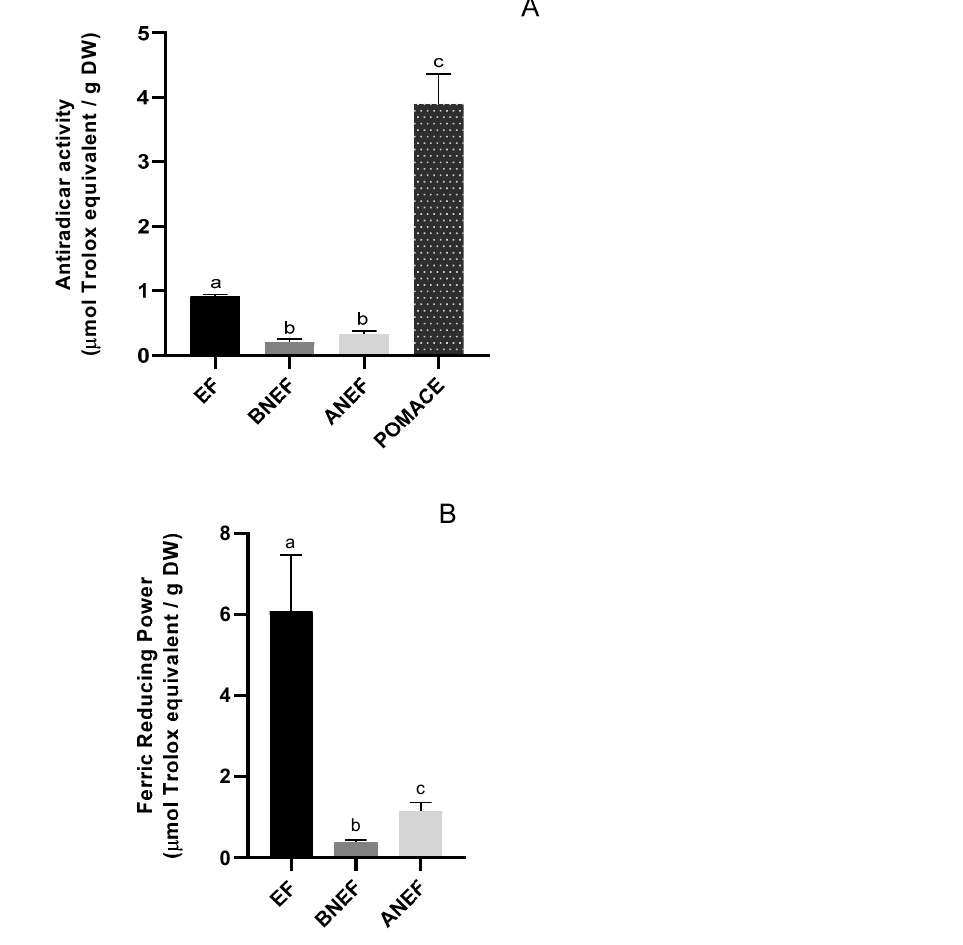
Figure 2. ( A )-Antiradical activity of extractable (EF) and non-extractable fractions (BNEF and ANEF), together with insoluble pear pomace. ( B )-ferric reducing power of extractable (EF) and non-extractable fractions (BNEF and ANEF). Columns with different letters are statistically different ( p < 0.05).